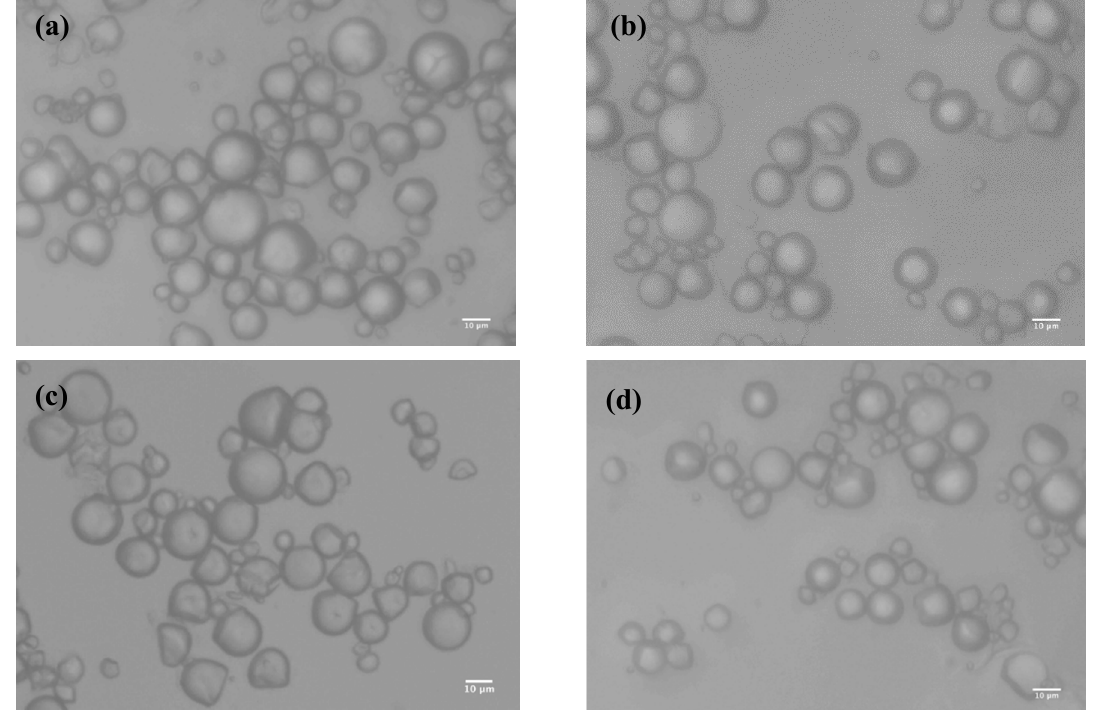
Figure 3. ( a ) Impact of substrate concentration on enzyme adsorption. ( b ) Correlation between enzyme adsorption and hydrolysis yield (10% of starch).